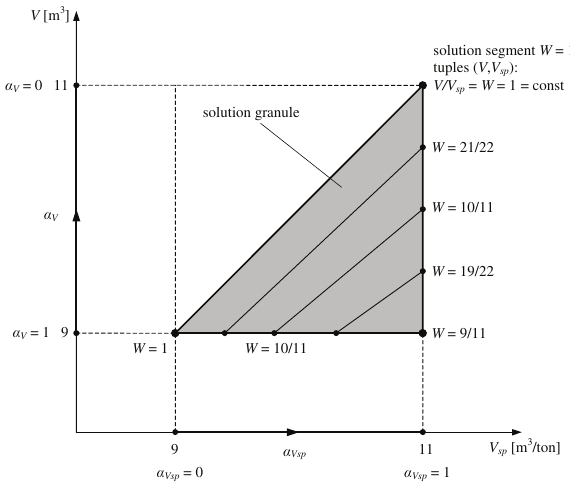
Fig. 13. Visualisation of the solution granule of the same IPVs division from Example 5. Variables α V and α V partially dependent: α V (cid:3) α V